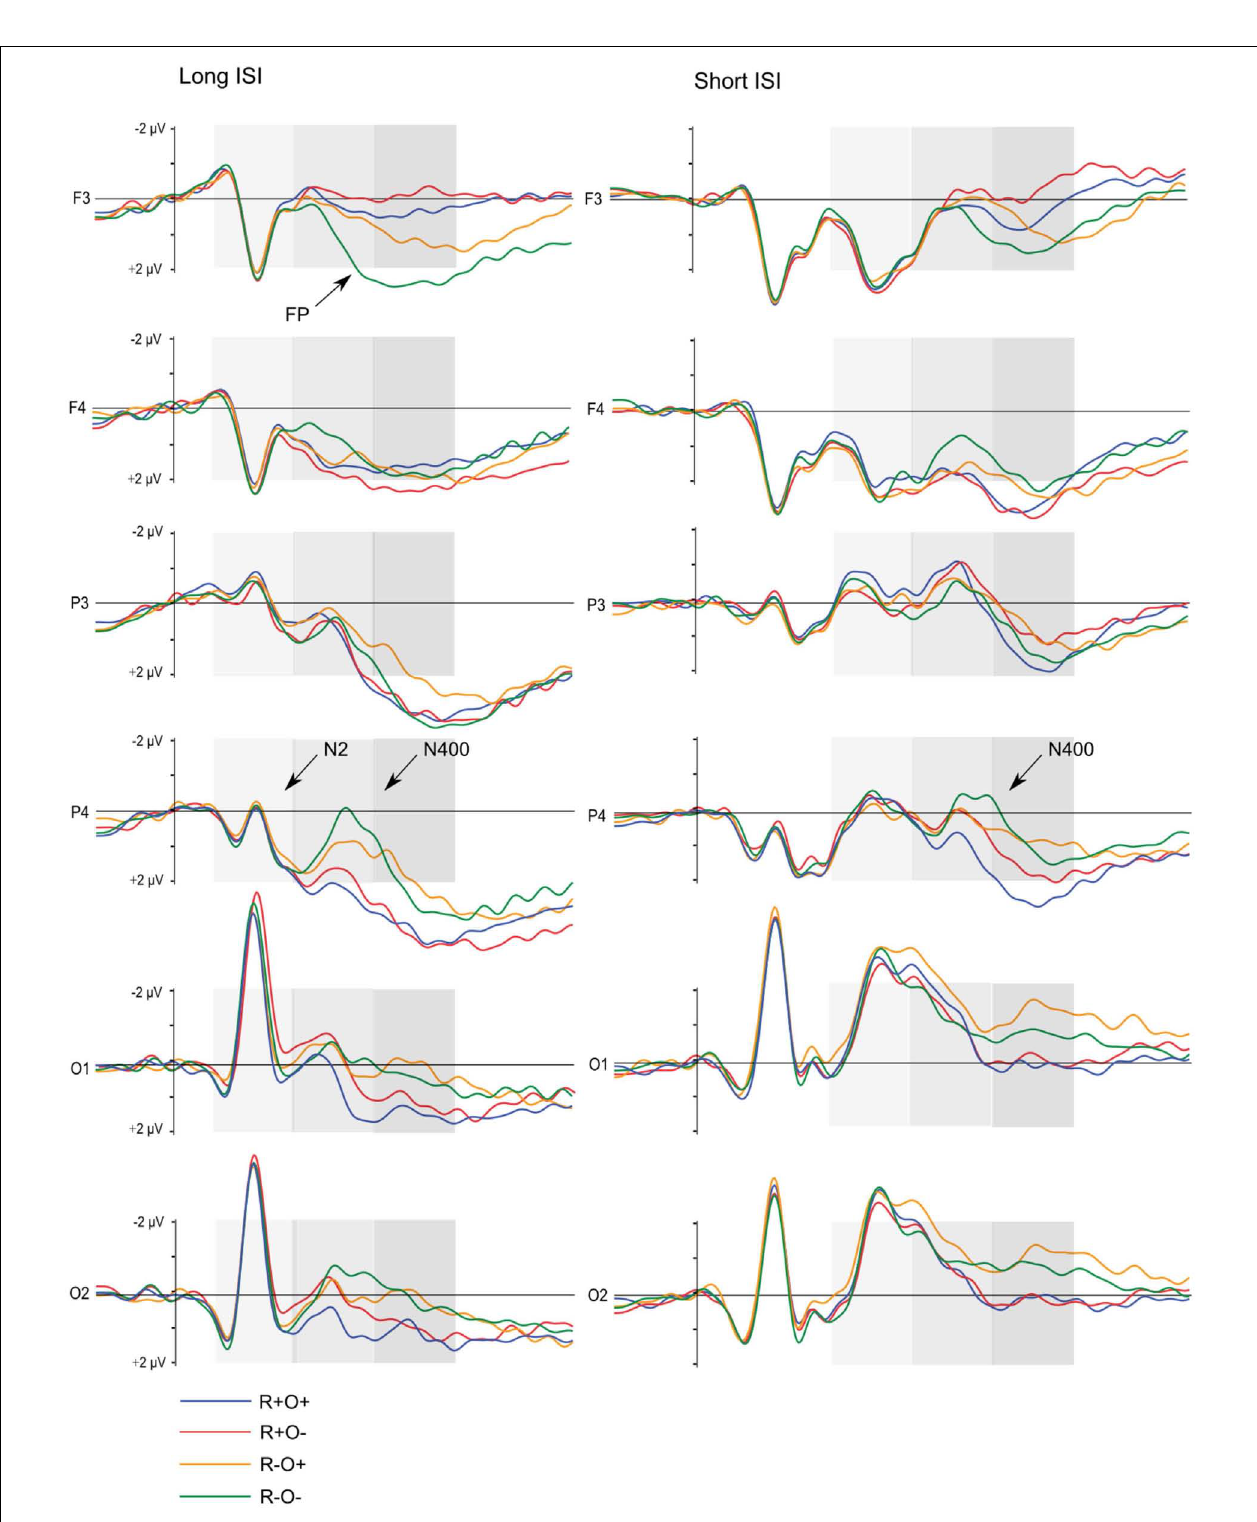
FIGURE 4 | Grand average ERP waveforms elicited by R + O + , R + O − , R − O + , and R − O − target words in long and short ISI, all participants. The shaded areas mark the 100–300, 300–500, and 500–700ms time-windows, respectively.